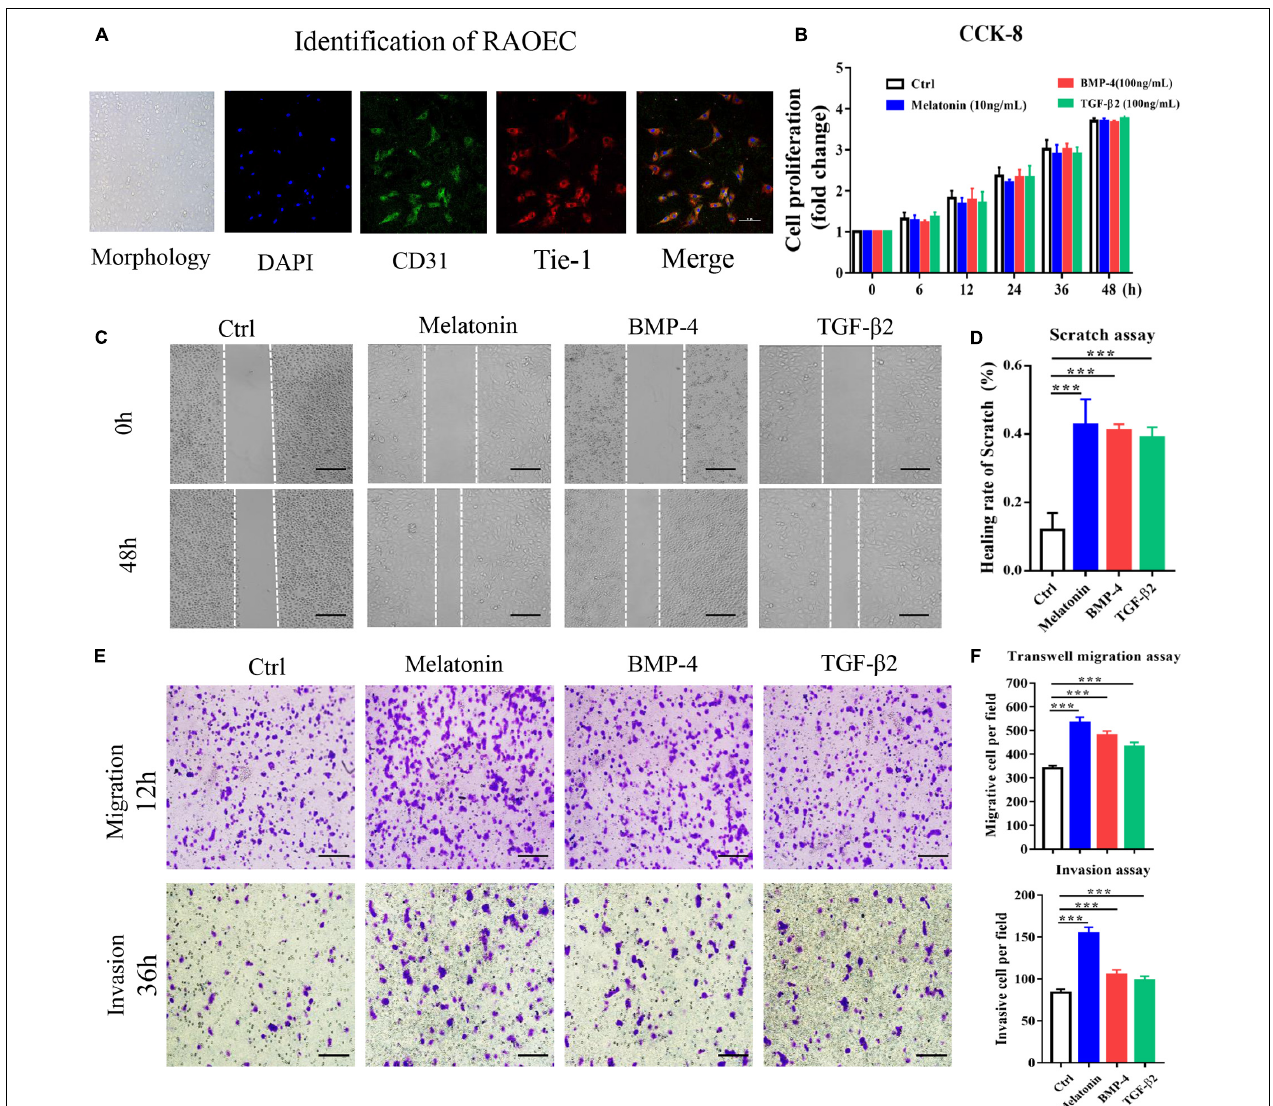
FIGURE 4 | Melatonin induces EndMT in RAOECs. Primary RAOECs were cultured with melatonin, BMP-4 or TGF- β 2 for 48 h. (A) The morphology of primary RAOECs and identification of primary RAOECs with CD31 and Tie-1 antibodies by IFC. Scale bar, 20 µ m. (B) Cell viability was assessed by the CCK-8 assay. (C) Migratory function was evaluated by scratch, transwell and invasion migration assays (E) with quantitative analysis (D,F) . Images of the scratch, transwell and invasion migration assays, showing that melatonin increased RAOEC migration compared with the control treatment. Scale bar, 50 µ m. The data represent the mean ± SD. ***P < 0.001 versus the control